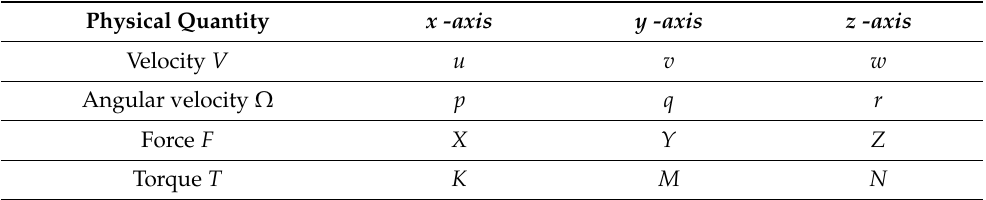
Table 1. Description of system